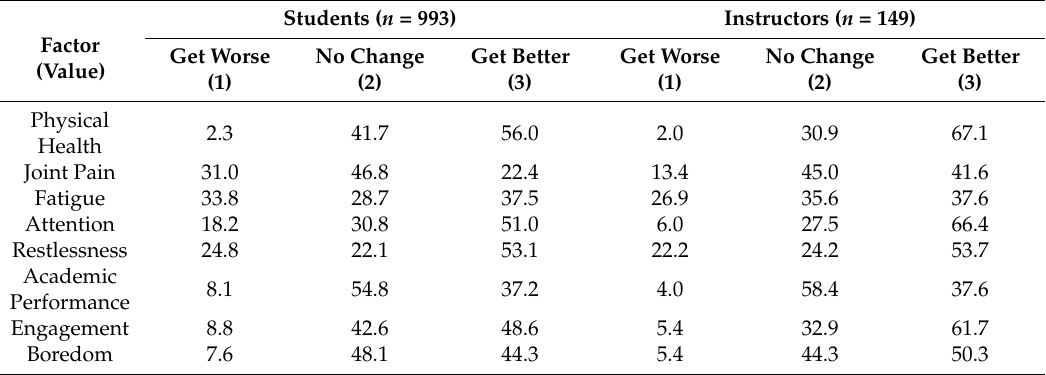
Table 4. Students’ and instructors’ predicted changes in health and academic outcomes if standing desks were made available in college